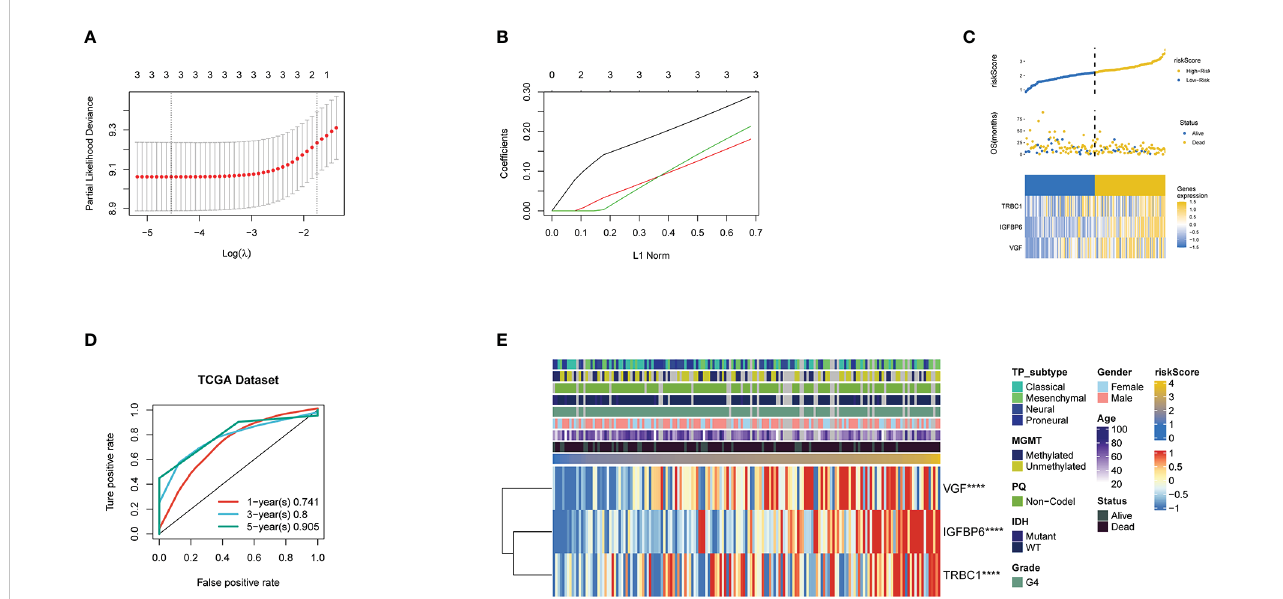
FIGURE 2 (A) Con fi dence interval under each lambda. (B) Trajectory of each independent variable, wherein the horizontal axis represents the log value of the independent variable lambda and the vertical axis represents the coef fi cient of the independent variable. Three lines of different part colors represent the three prognostic genes. (C) Risk Score, survival status and the expression of three genes in the whole TCGA dataset. (D) ROC curve and AUC of the three-gene signature.ROC curve measuring the sensitivity of risk score in predicting the 1-year, 3-year, and 5-year survival of the patients. The area under the ROC curve was 0.741, 0.8, and 0.905, respectively. (E) Heatmap of the three prognostic genes. **** Represents P